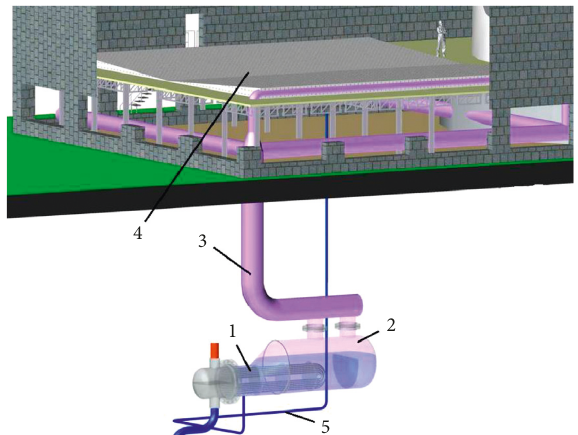
Figure 6: 3D model of the secondary circuit: (1) tubular steam generator; (2) steam generator body; (3) steam pipeline; (4) air heat exchanger-condenser; (5) condensate return pipeline. Table 4: The main design parameters of the steam generator. Parameter